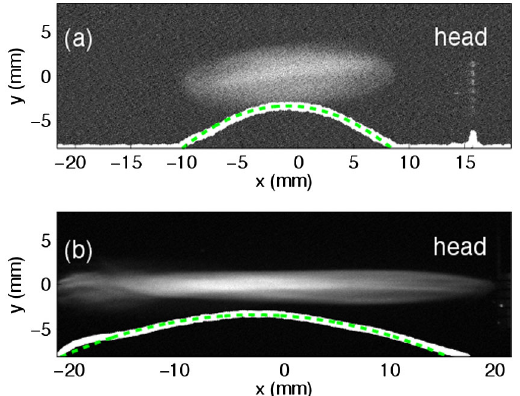
FIG. 13. Measured rms electron-bunch duration (symbols) as a function of charge for two cases of laser transverse spot size (cid:2) c on the photocathode. The dashed red and blue lines are the corresponding simulations carried with ASTRA . The dashed cyan line represent the UV laser pulse